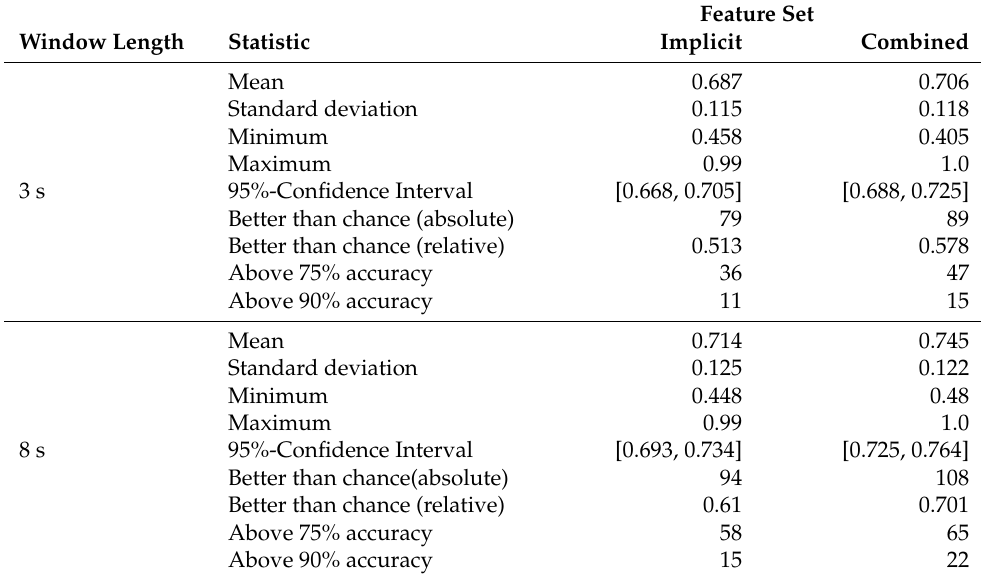
Table 2. Statistical values representing the classification results of all 154 participants for 3 and 8 s windows to compare the implicit and combined feature